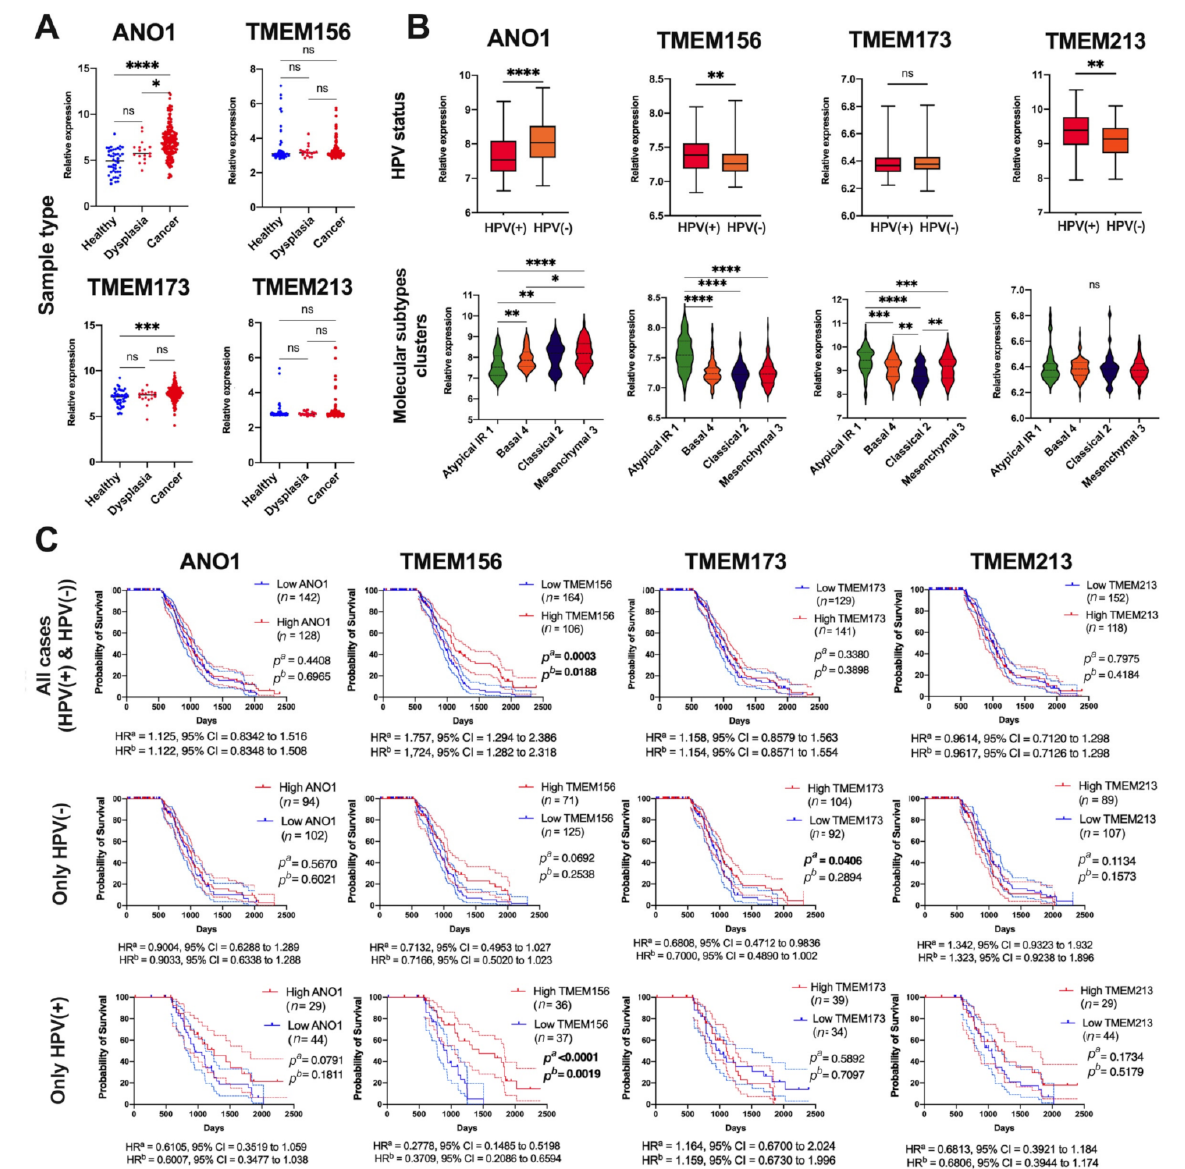
Figure 7. Validation of ANO1 , TMEM156 , TMEM173, and TMEM213 in HNSCC patients using GEO datasets: ( A ) expression level of TMEM s depending on sample types, based on GSE30784; ( B ) expression level of TMEM s depending HPV status, and TMEM s levels in different types of HNSCC divided into molecular clusters and ( C ) OS of HNSCC patients depending on TMEMs levels in all cases, only in HPV( − ) and only in HPV(+) patients, based on GSE65858; Mann–Whitney U or t -test or one-way ANOVA test with post-test; ns : not significant, * p < 0.05, ** p < 0.01, *** p < 0.001, **** p < 0.0001; p a —log-rank (Mantel–Cox) test, p b —Gehan-Breslow-Wilcoxon Test; HR a —Hazard Ratio-Mantel–Haenszel, HR b —Hazard Ratio-logrank; CI—confidence interval; p < 0.05 considered as